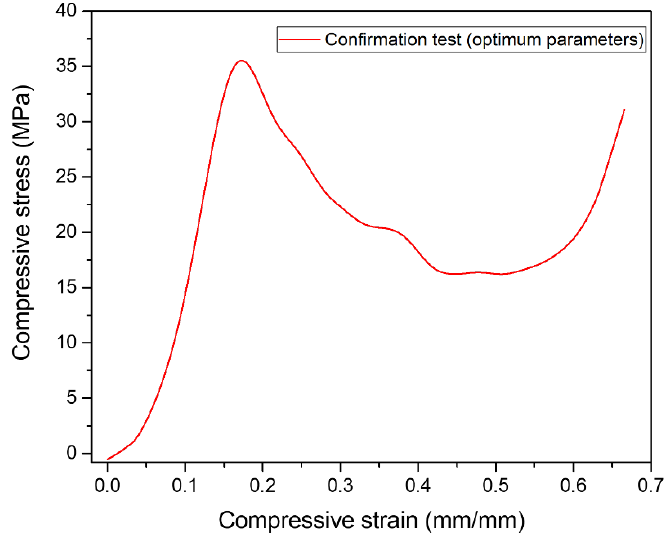
Figure 15. Compressive stress–strain diagram of confirmation test at optimum parameters.